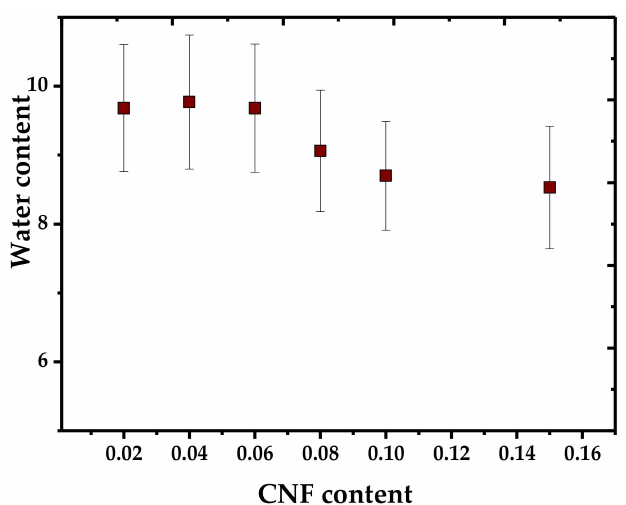
Figure 14. Water uptake trend in respect to CNF content in TPS matrix. Prepared from data in [33].